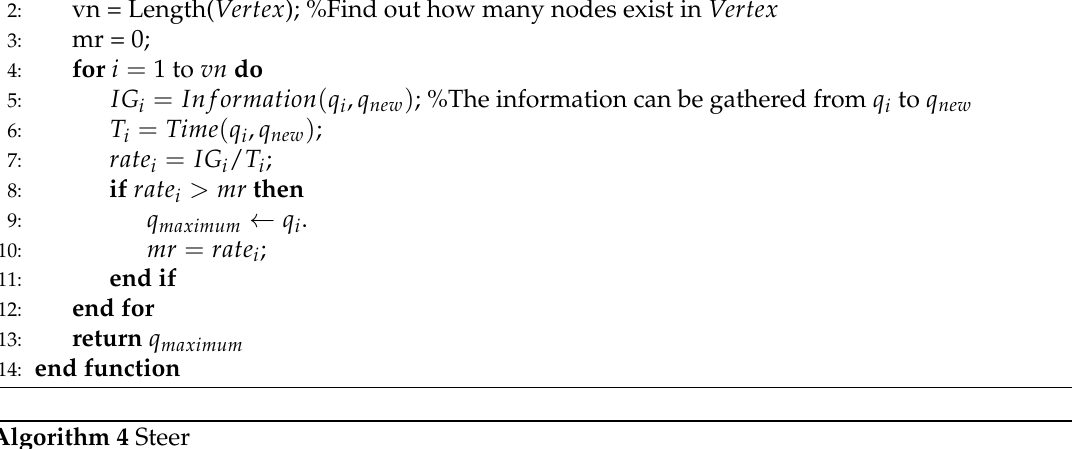
Algorithm 4 Steer